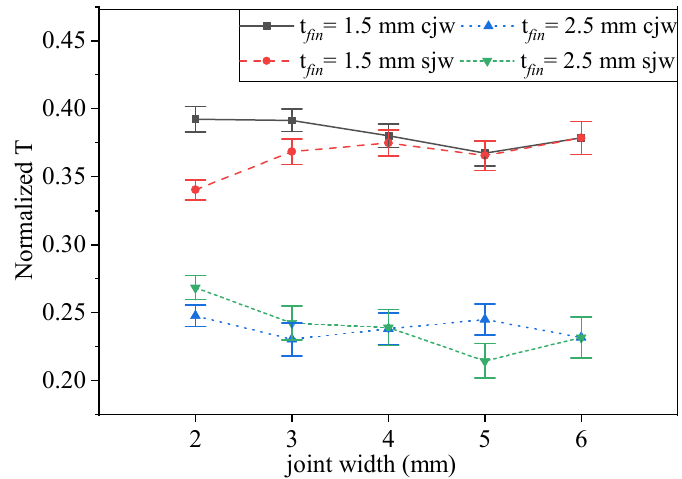
Figure 6. Variation of each kinematic parameter’s average normalized T with joint width.